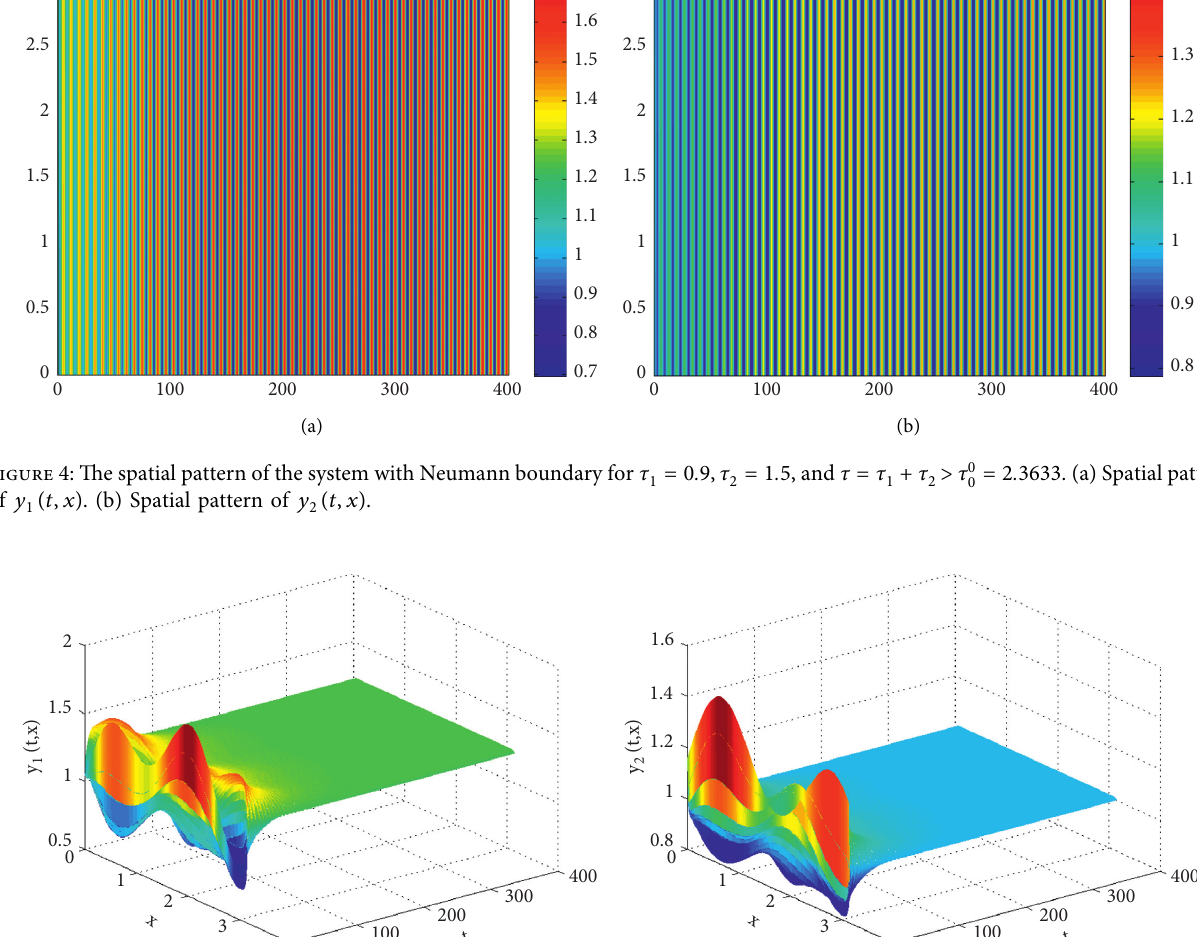
� 0 . 9, τ � 0 . 9, and 1 2